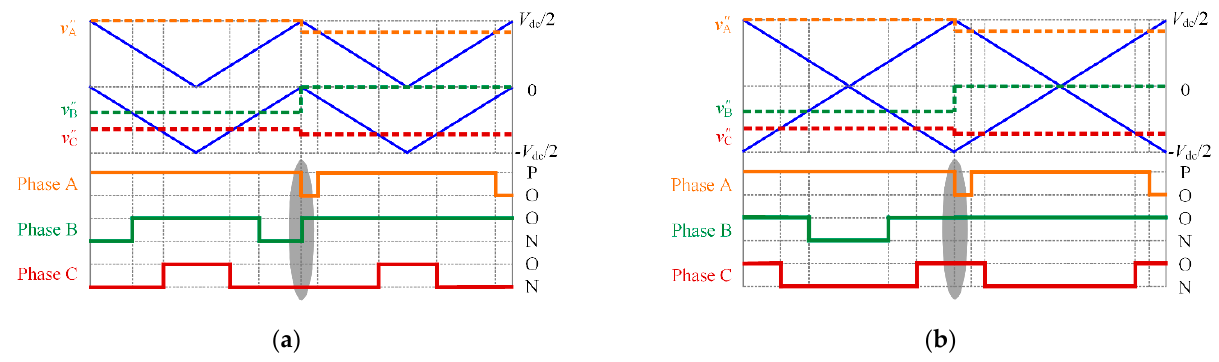
Figure 7. The switching sequence of the transition from region R III to R I . ( a ) Phase disposition condition; ( b ) Phase opposition disposition condition.